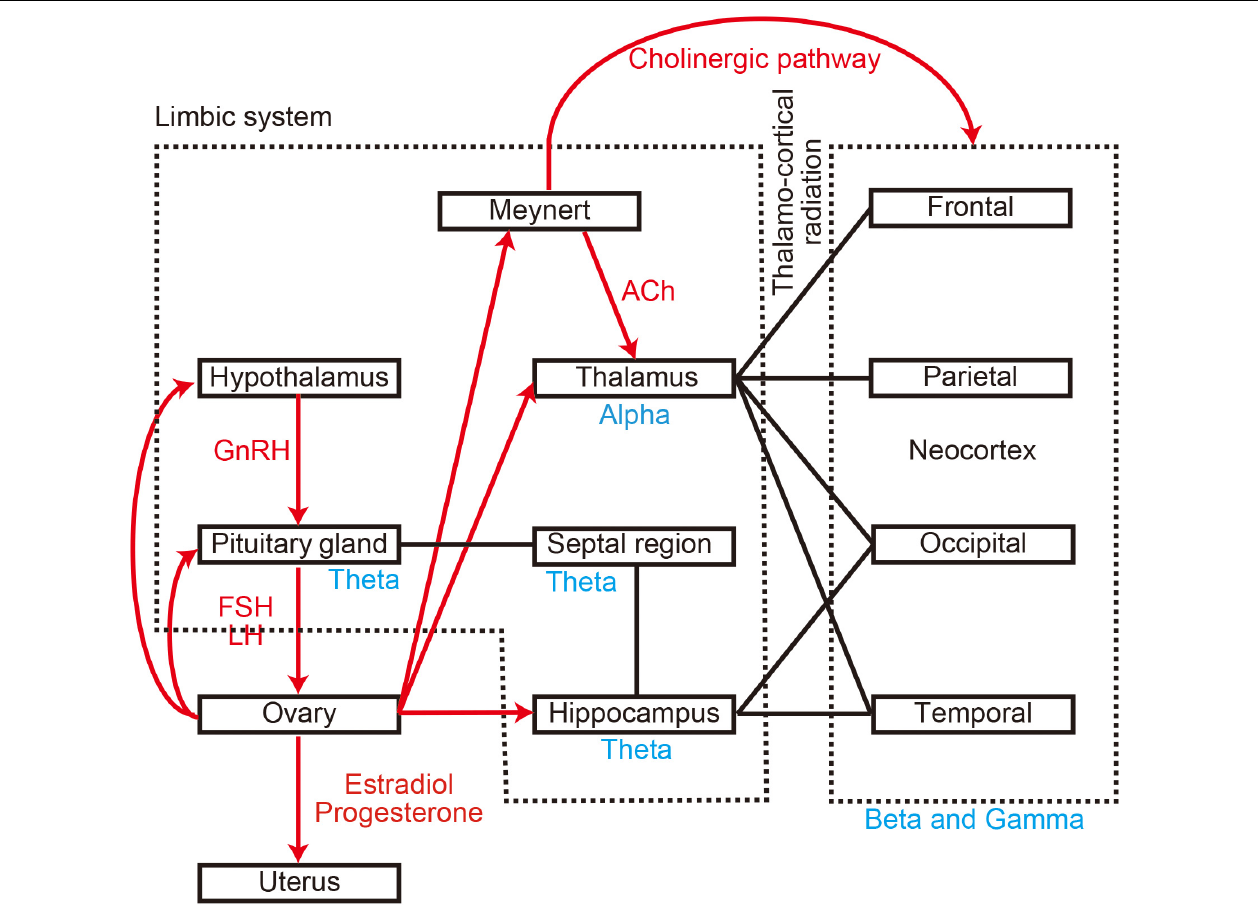
FIGURE 1 | Anatomical and molecular relationship between brain regions. Black lines represent anatomical connections. Red arrows represent molecular connections. Blue words indicate generators of oscillatory activity. GnRH, gonadotropin-releasing hormone; FSH, follicle-stimulating hormone; LH, luteinising hormone; Ach,